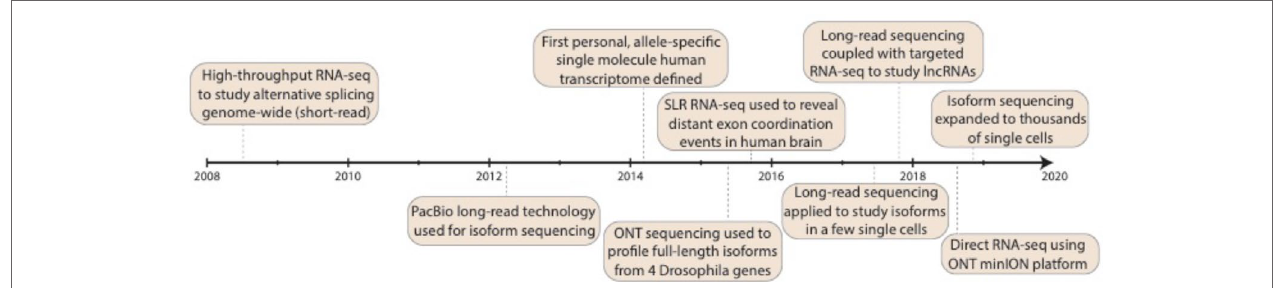
FIGURE 1 | Progress in isoform sequencing. Timeline highlights some of the key milestones in the history of isoform sequencing, dating back to the advent of short-read RNA-seq back in 2008. Note that this is presented as a summary only and is not intended to be exhaustive of all work done in the field. RNA-seq: RNA sequencing; PacBio: Pacific Biosciences; SLR: synthetic long-read; lncRNA: long noncoding RNA; ONT: Oxford Nanopore